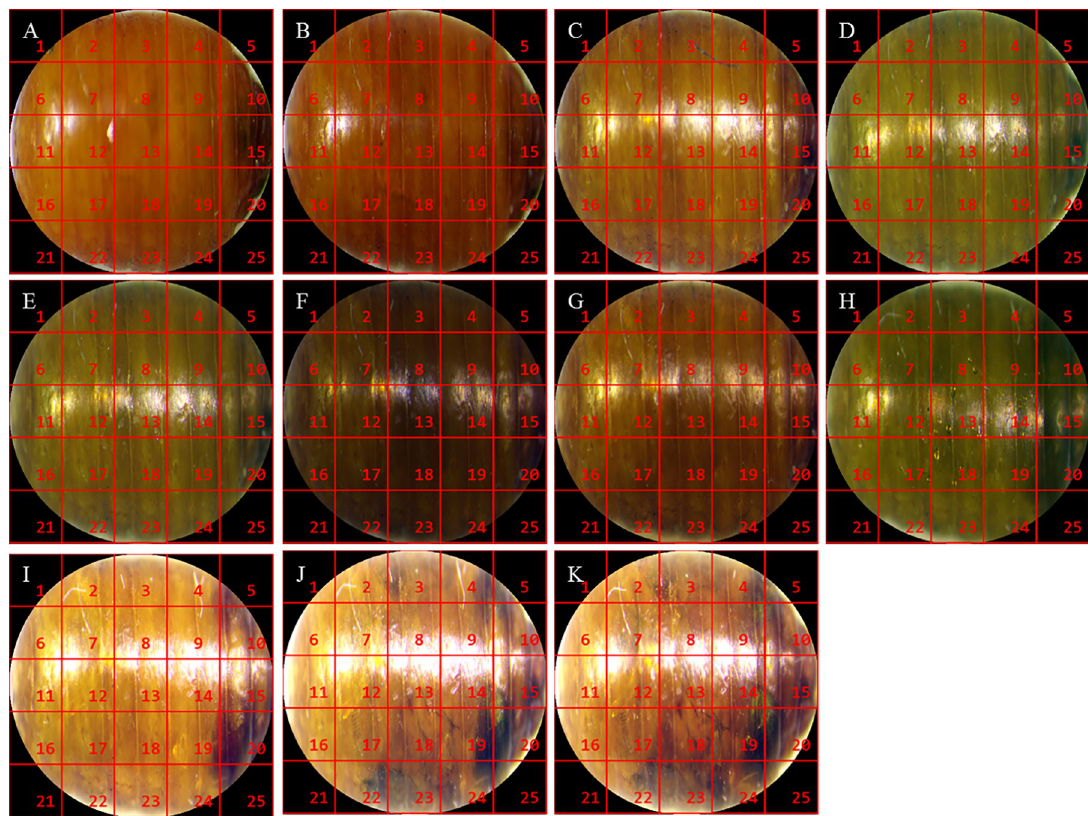
Fig 1. Meshed and equalized pupal images. Note: Fig 1A–1K respectively represent the mesh characteristics of Z . cucurbitae (Coquillett) pupae from day 1 to day 11.